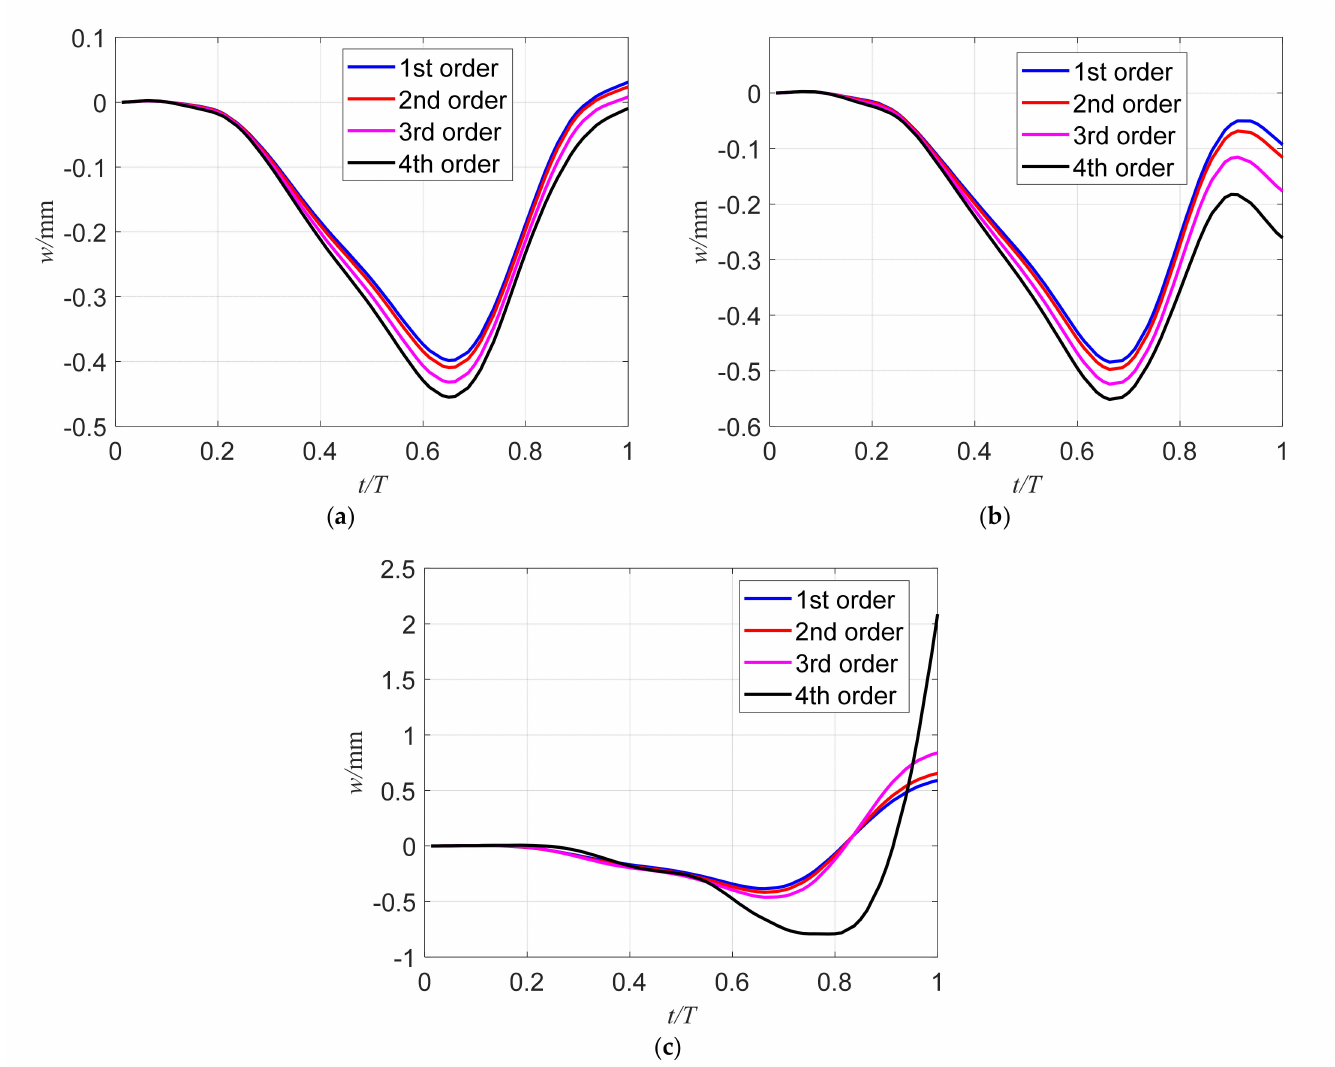
Figure 8. Dynamic response of partially covered plate with patch size 0.08 m × 0.08 m after the first four order damping loss factor optimizations for CFFF, SFSF, CFSG. ( a ) CFCF; ( b ) SFSF; ( c )